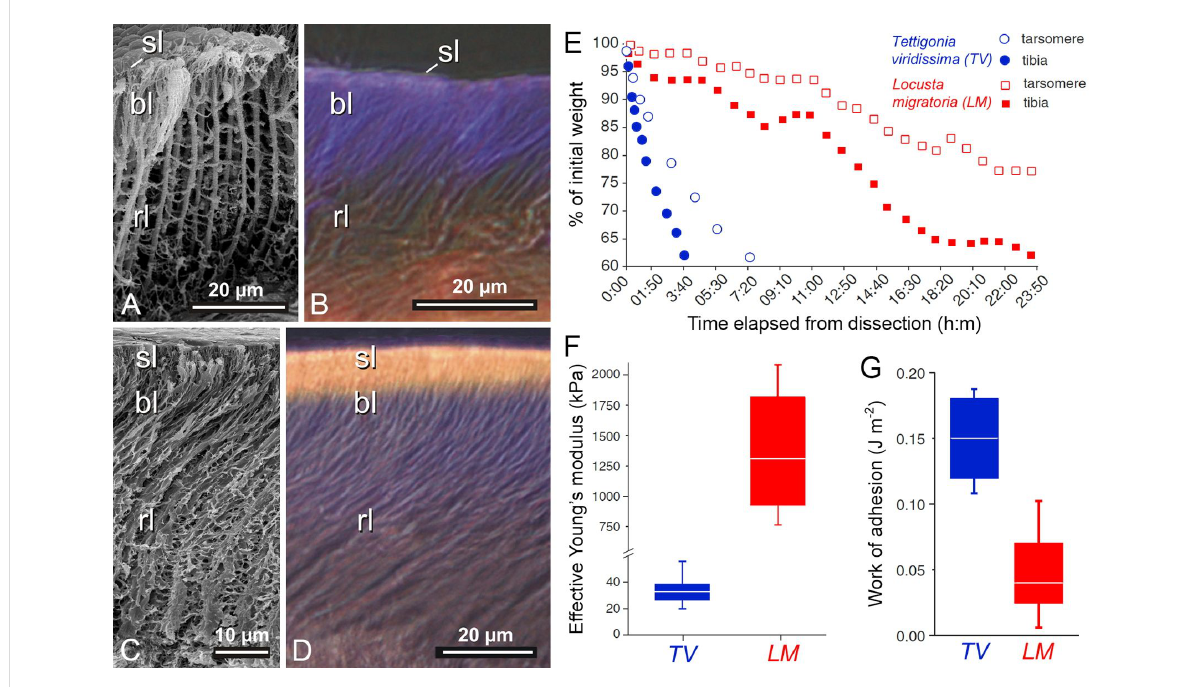
Figure 6: Material structure and properties of orthopteran adhesive pads (euplantulae). (A, B) Great green bush-cricket ( Tettigonia viridissima ). (C, D) Migratory locust ( Locusta migratoria ). (A, C) Scanning electron micrographs showing frozen, fractured, substituted, dehydrated and critical point dried pads. (B, D) Wide-field fluorescence micrographs showing frozen-cut pads. Structures with large proportions of resilin are violet/blue. sl, superficial layer; bl, layer of branching rods; rl, layer of primary rods. (E) Desiccation dynamics of tarsi and pieces of tibiae cut off the body in both species. (F) Effective Young's modulus of attachment pads of both species determined by means of indentation with a spherical tip radius of 250 µm. (G) Work of adhesion of attachment pads of both species measured by means of indentation with a sphere with a radius of 32 µm. In F and G, the ends of